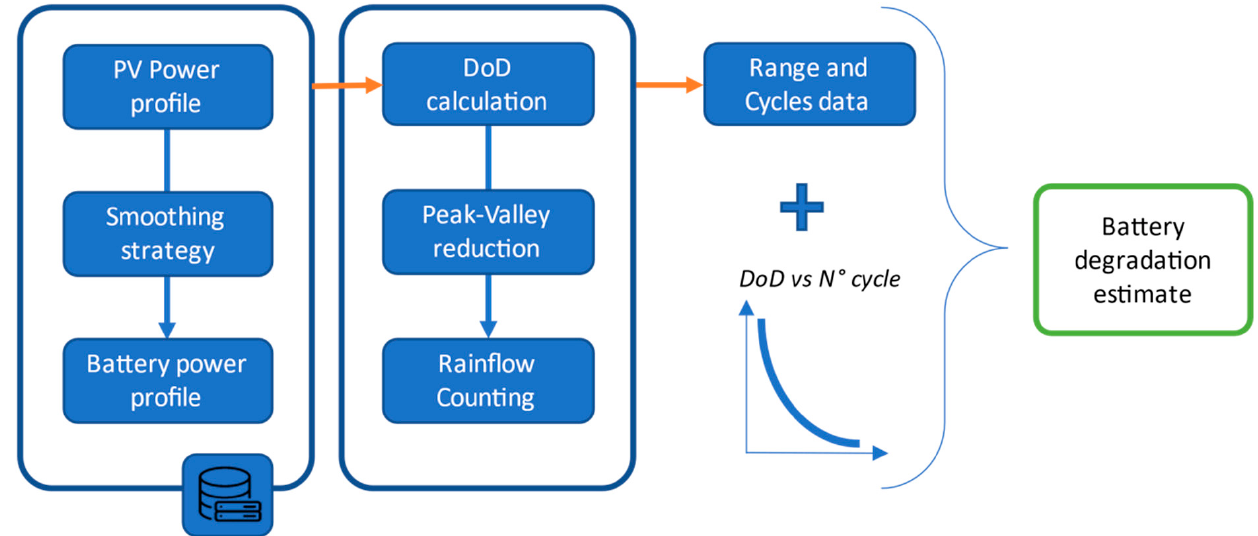
Figure 2. Flowchart of event-based battery degradation modeling.